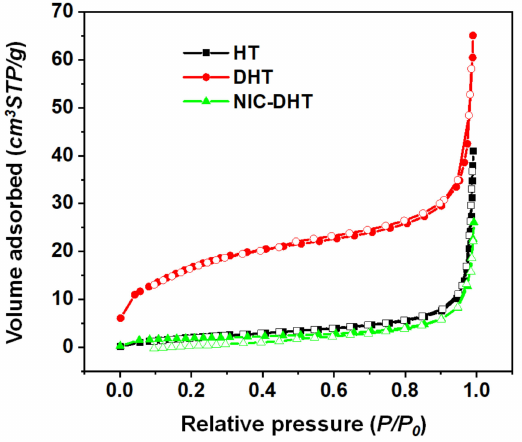
Figure 3. The N2 adsorption–desorption isotherms of HT, DHT, and NIC–DHT.